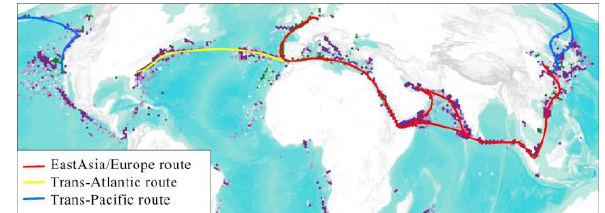
Figure 4 Trend analysis on counted AIS’ positions over all bin locations, focus on the East Asia/Europe route. (Basemap sources: Esri, USGS, NOAA).